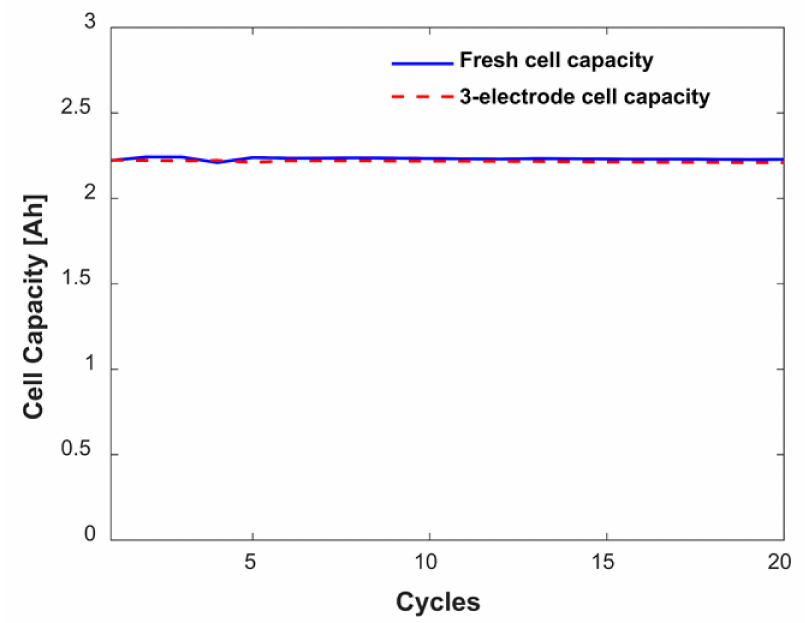
Figure 9. Comparison between fresh cell and three-electrode cell capacity